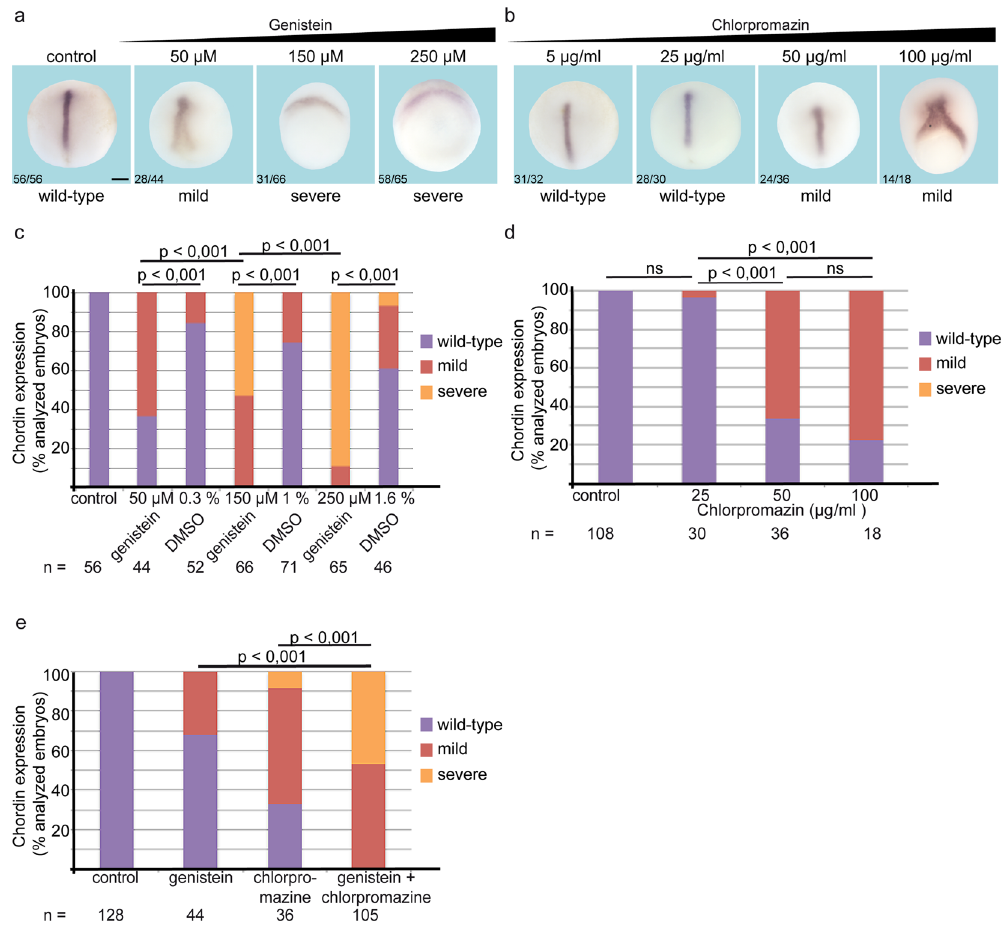
Figure 3. Endocytosis is necessary for convergent extension movements. Wild-type embryos were incubated from stage 9 to stage 14 in MBSH containing the indicated concentration of genistein ( a ) or chlorpromazine ( b ). ( c ) Quantification of the chordin expression revealed that genistein blocked convergent extension movements even at low doses (50 µ M). At high doses (250 µ M), almost all embryos showed the severe phenotype with chordin being expressed at the dorsal side of the open blastoporus, whereas 60% of the DMSO-treated siblings expressed chordin in a wild-type pattern. ( d ) Quantification of the chordin expression revealed that 50 µ g/ ml chlorpromazine induced a mild mislocalization of chordin expression in more than 60% of the embryos. Doubling of the dose to 100 µ g/ml increased the frequency of chordin mislocalization to more than 70%. e) Simultaneous treatment with both inhibitors revealed additive effects. Quantification of chordin mislocalization revealed that both inhibitors together inhibit convergent extension movements even at doses when one inhibitor alone has only mild effects. n: number of embryos, p-values according to χ 2 test. n.s. not